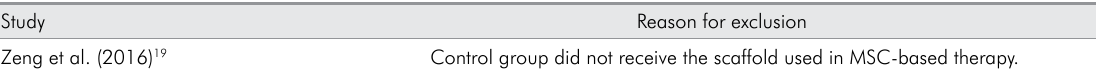
Table 1. Excluded